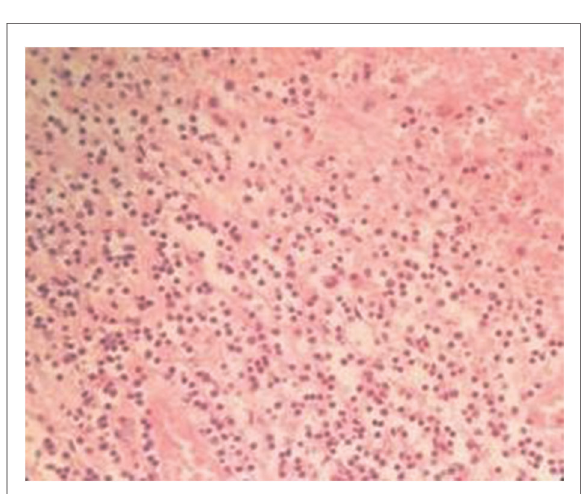
FIGURE 7 The pathology of the splenic pedicle (magni fi cation×400).